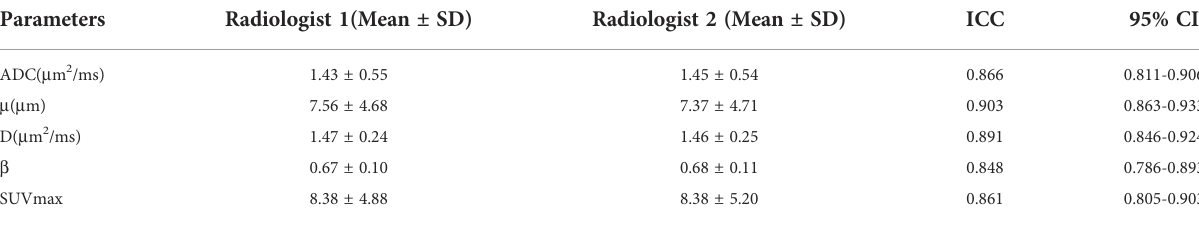
TABLE 4 Comparison of different parameters between the benign and malignant SPLs groups, and between AC and SCC groups. Parameters